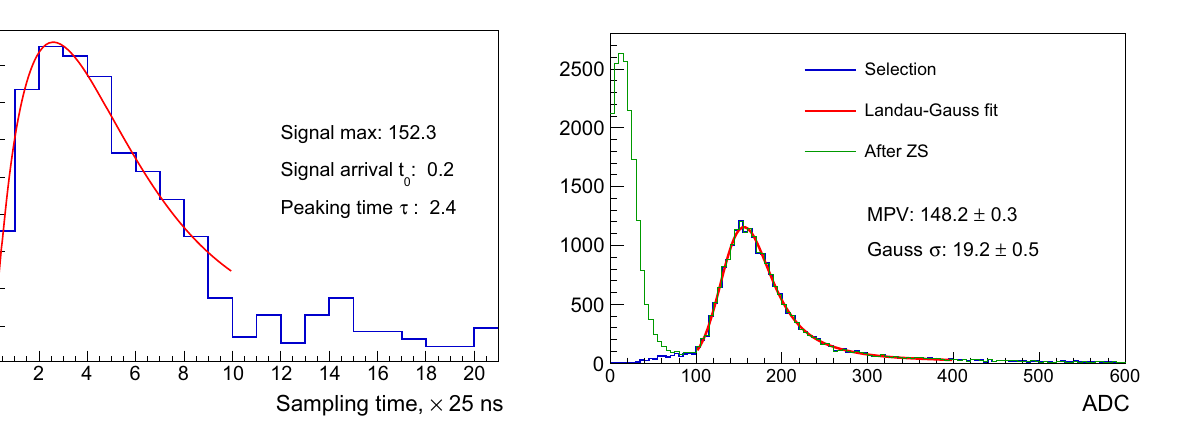
Fig. 8 Signal waveform sampled in 25 ns time intervals. The red line is a fit with CR-RC-response function of Eq. (2)